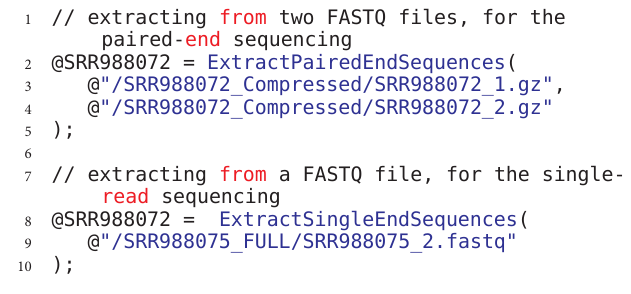
FIGURE 2 | Formats of data representation in particular phases of the EPS